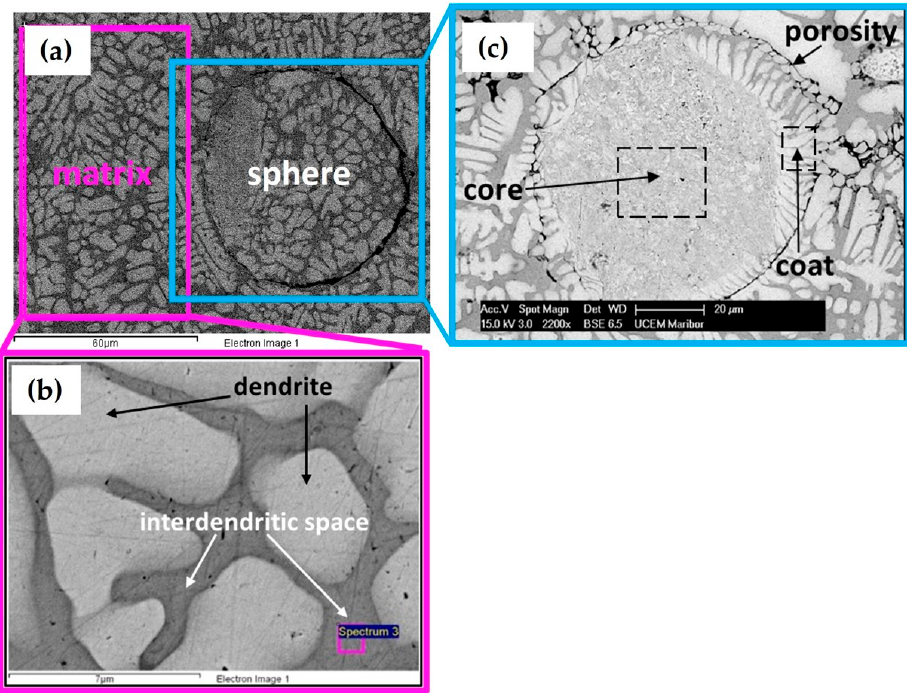
Figure 2. Cast microstructure of Ag 20 Pd 20 Pt 20 Cu 20 Ni 20 (20 at. %) ( a ) Matrix and sphere ( b ) Sphere with centre and coat ( c ) Matrix with dendrite and interdendritic space.